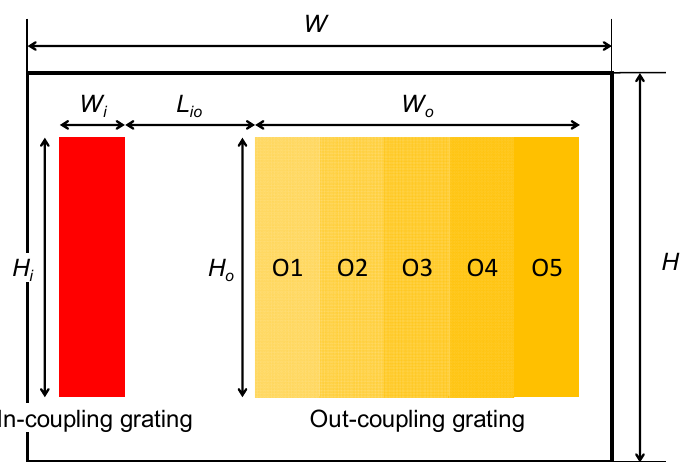
Figure 2. Plan view of dual-channel waveguide. To evenly expand the pupil, the out-coupling grating consists of five sub-gratings—abbreviated as O1/O2/O3/O4/O5—with their diffraction efficiencies being modulated. W / H / D is the width/height/thickness of waveguide, W i/o / H i/o the width/height of in/out-coupling grating, and L io the distance between the in-coupling and out-coupling grating. Table 1. Parameters of waveguide and gratings.